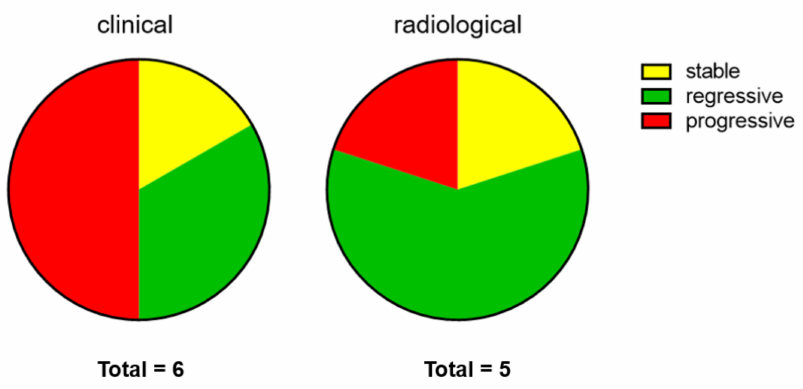
Figure 4. Objective evaluation of bisphosphonate therapy effects by dermatologists (clinical) and radiological